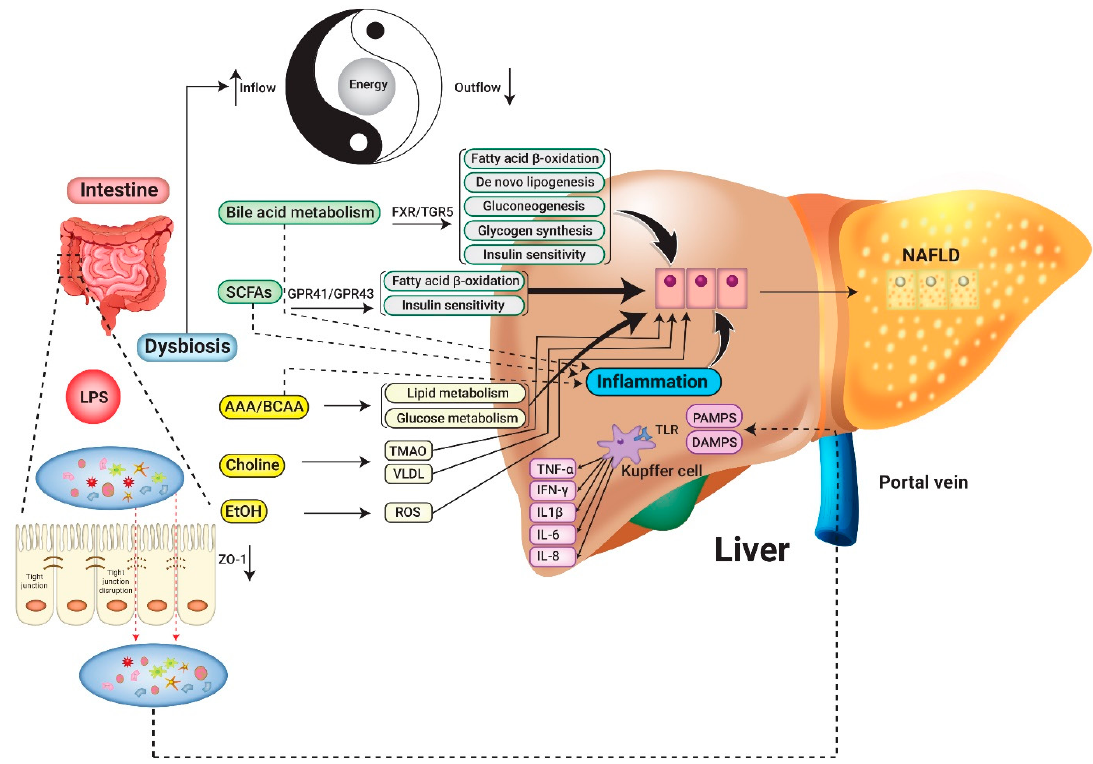
Figure 1. The roles gut microbiota play in liver steatosis. LPS: lipopolysaccharide; SCFAs: short-chain fatty acids; AAA: aromatic amino acids; BCAA: branched-chain amino acids; EtOH: ethanol; FXR: farnesoid X receptor; TGR5: transmembrane G protein-coupled receptor 5; GPR: G protein-coupled receptor; TMAO: trimethylamine-N-oxide; VLDL-C: very-low-density lipoprotein cholesterol; ROS: Reactive oxygen species; TNF- α : tumor necrosis factor-alfa; IFN- γ : Interferon-gamma; IL-1 β : interleukin 1beta; IL-6: interleukin 6; IL-8: interleukin 8; TLR: toll-like receptor; NAFLD: Non-alcoholic fatty liver disease.